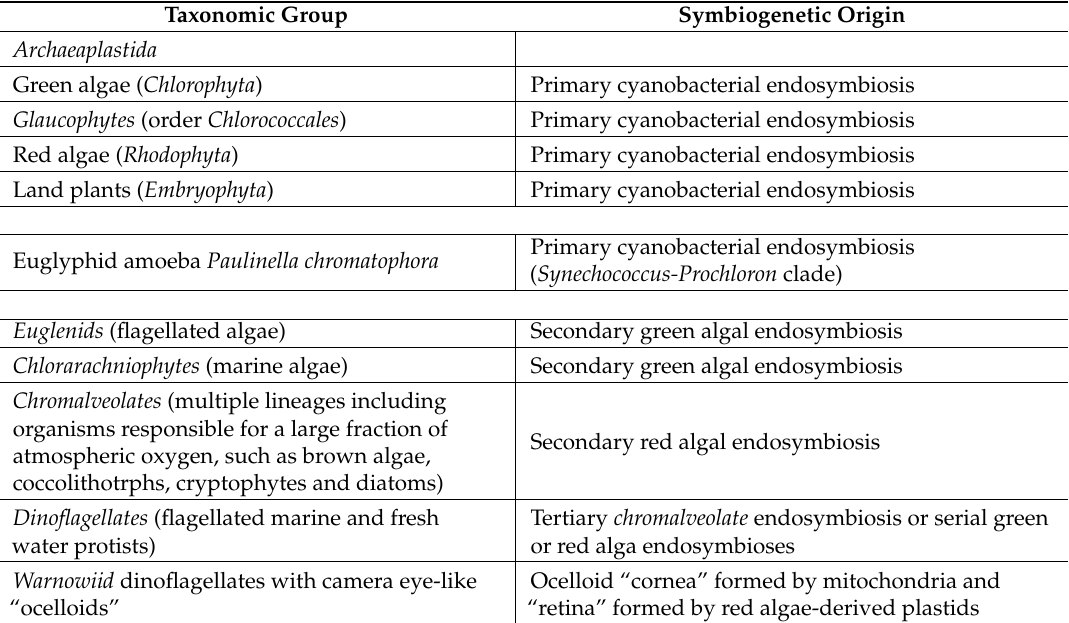
Table 3. Photosynthetic eukaryotic lineages resulting from symbiogenesis. Taxonomic